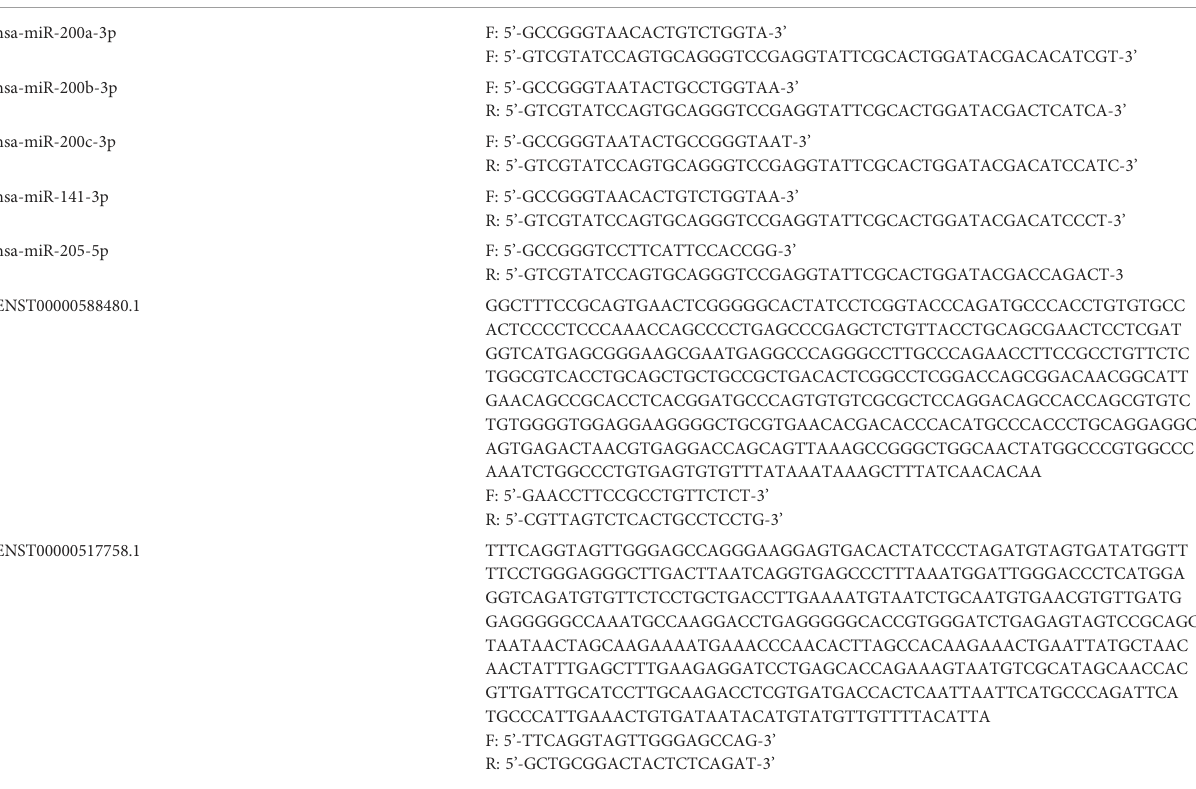
TABLE 2 The PCR